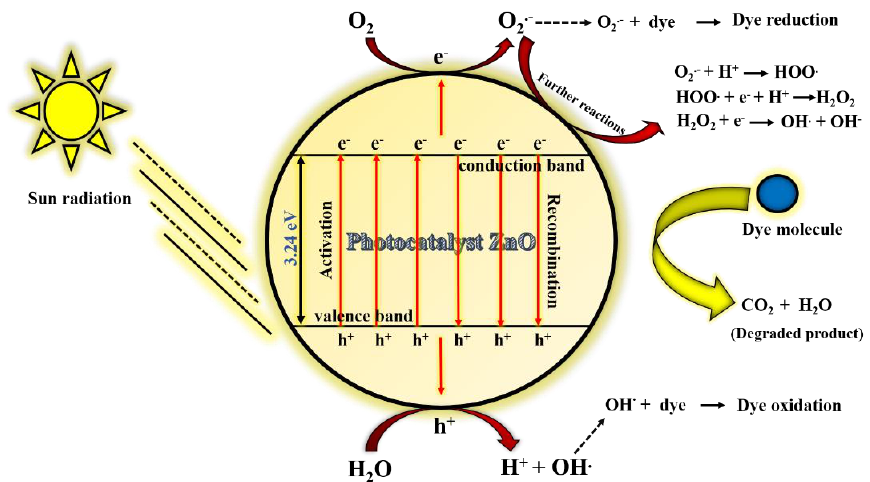
Figure 8. Schematic diagram of photocatalysis mechanism of ZnO NPs.